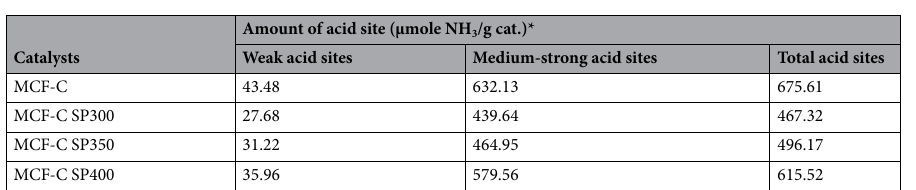
Table 3. Acidity and acid strength of the fresh and spent catalysts obtained from NH 3 -TPD. *Amounts of acid sites of catalyst were calculated by NH 3 -TPD (employ of Fityk program evaluation).